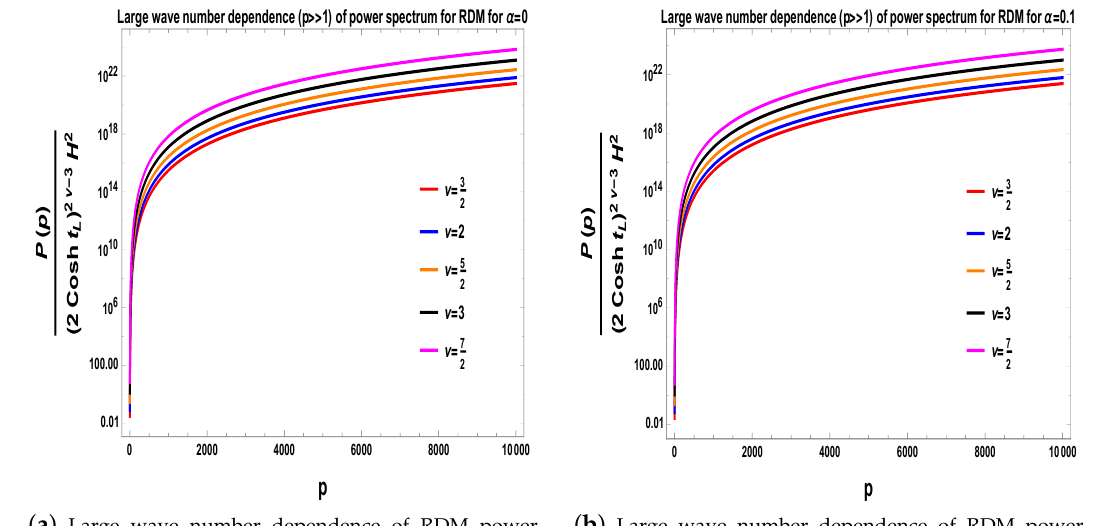
( b ) Large wave number dependence of RDM power spectrum for α = 0.1.